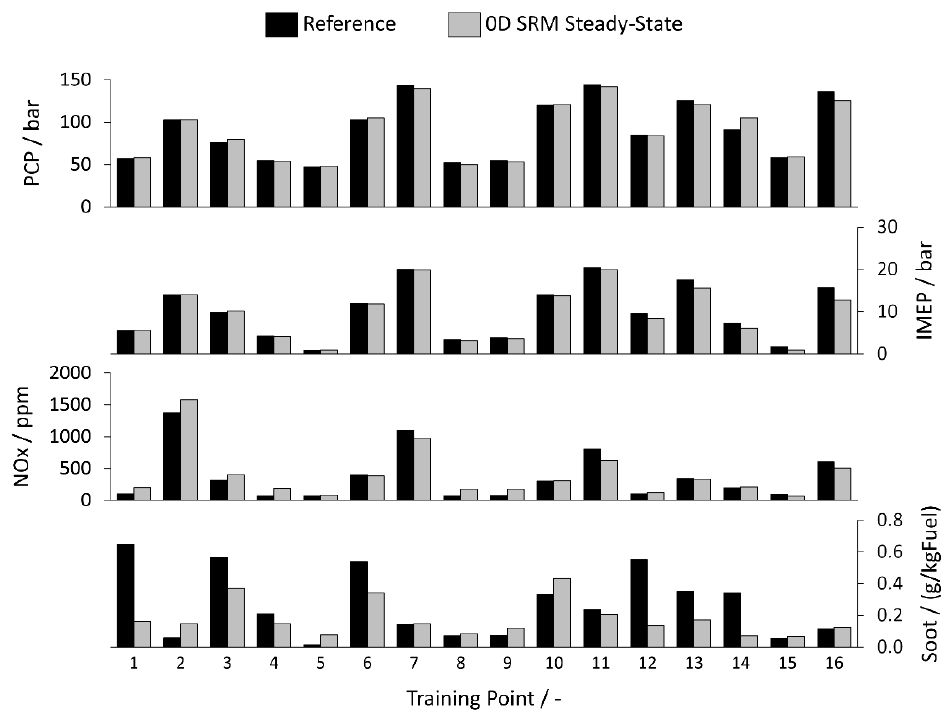
Figure 5. Performance and emission results from the three-stage optimization campaign of the 0D